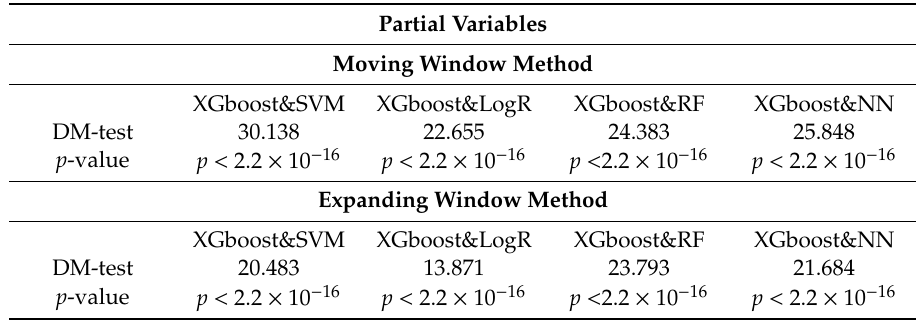
Table 8. The results of the Diebold–Mariano test (partial variables).